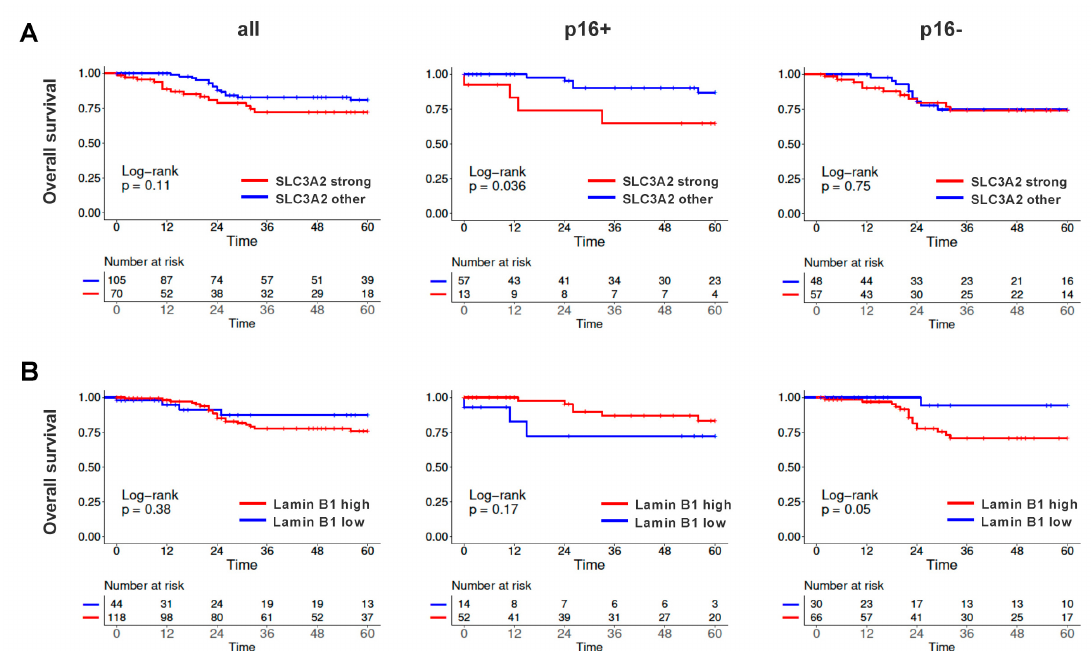
Figure 7. Patient survival in dependence of the SLC3A2 or LRPPRC expression status. ( A ) Overall survival in dependence of SLC3A2 and p16 status. OPSCC were categorized as showing strong (3) vs. all other (0,1,2) staining intensities. ( B ) Overall survival in dependence of lamin B1 and p16 status. OPSCC were categorized as showing a low (0,1) vs. high (2,3) staining intensity.